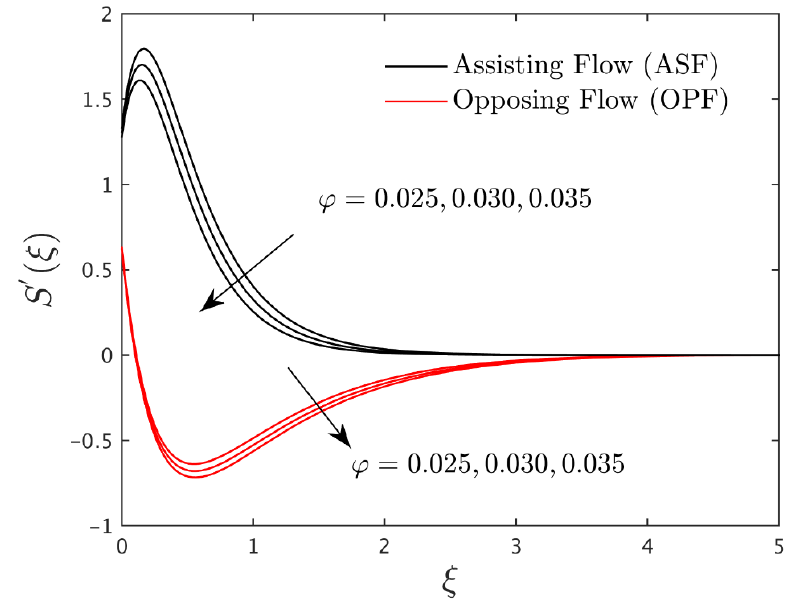
Figure 2. Velocity profile for the case of ASF and OPF due to variations in the values of